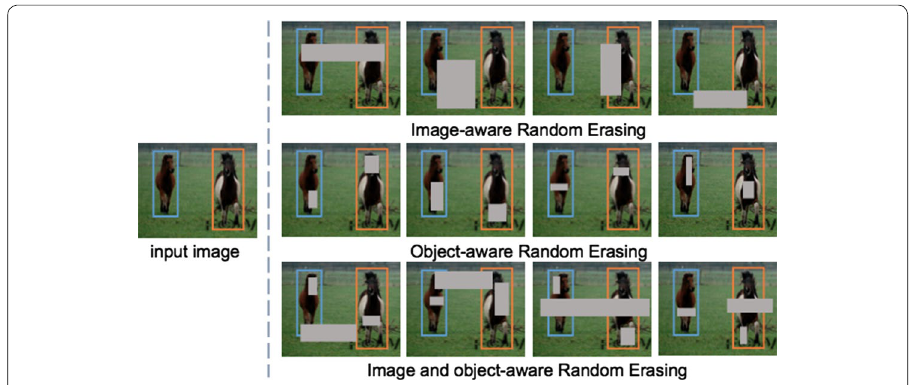
Fig. 12 Example of random erasing on object detection tasks [70]